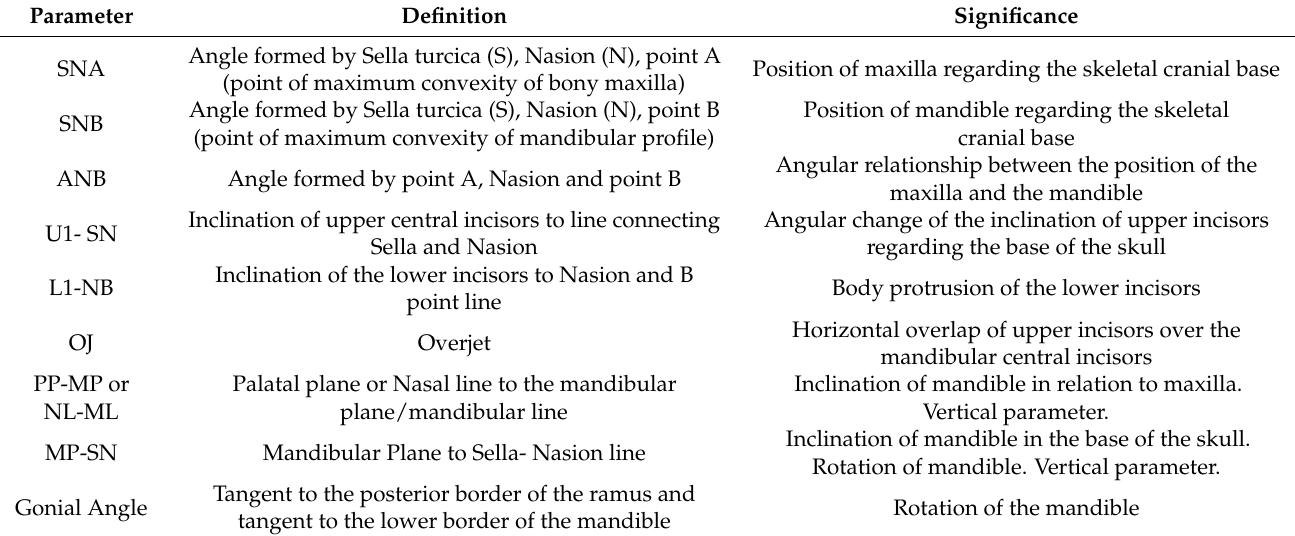
Table 1. Definition of cephalometric parameters and their